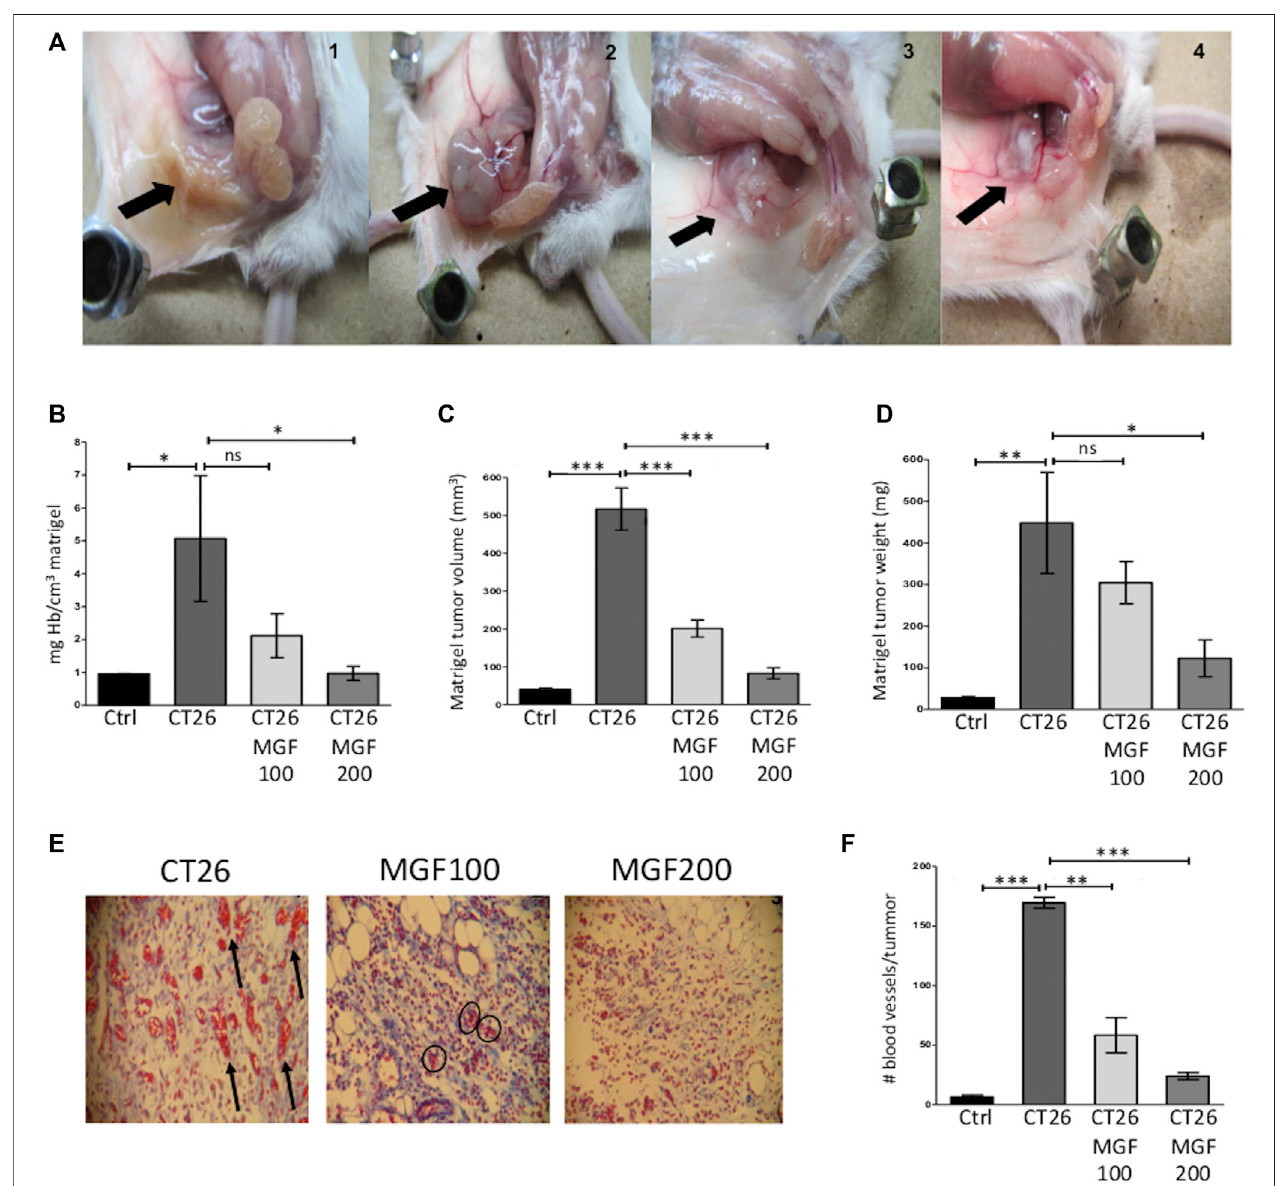
FIGURE 4 | MGF treatment has antiangiogenic effects in vivo CT26. WT matrigel plug angiogenesis model. BALB/c mice were subcutaneously implanted bith a basal control plug (Matrigel + heparin + PBS), CT26 tumor plug (basal control plug + CT26. WT cells (5 x 10 5 ). Treatment groups were implanted with a MGF200 plug (MGF 200 μ g/ ml + Matrigel, heparin, CT26. WT, PBS) or MGF100 plug (MGF 100 μ g/ ml + Matrigel, heparin, CT26. WT, PBS). Twelve days post-implantation, the subcutaneousmatrigelplugswereweighed,measured,andthecorrespondingvolumeswerecalculated.Hbreleaseofliqui fi edplugswasquanti fi edbytheDrabkin method. The histological analysis were staining by haematoxylin-eosin and subsequently with Masson ’ s trichrome dye. A microscopic count of the blood vessels was performed throughout the periphery of the tumours. (A) Macroscopic subcutaneous plug images from left to right basal control, CT26 tumor control, MGF 100 μ g/ ml treatment, MGF 200 μ g/ ml treatment (B) quanti fi cation of Hb content plug relative to tumor control plug (arbitrarily set at 100%) (C) volume of Matrigel plug (mm 3 ) (D) weight of Matrigel plug (mg) (E) staining with Masson ’ s Trichrome of tumour samples. Left picture, tumour positive control plug shows numerous macro- and microvessels in the tumour periphery area, the arrow points are indicative of larger calibre blood vessels; middle picture, tumor plug with MGF100 μ g/ mL shows few remaning small vessels in the matrigel (circle marks); right picture, in tumor plug with MGF 200 μ g/ ml no blood vessels can be observed in the matrigel, magni fi cation × 100. (F) Quanti fi cationofthenumberofbloodvesselsintheentiretumourperipheryarea.Dataarerepresentedasmean ± SD;notsigni fi cant(ns),signi fi cant,* p < 0.05; *** p <